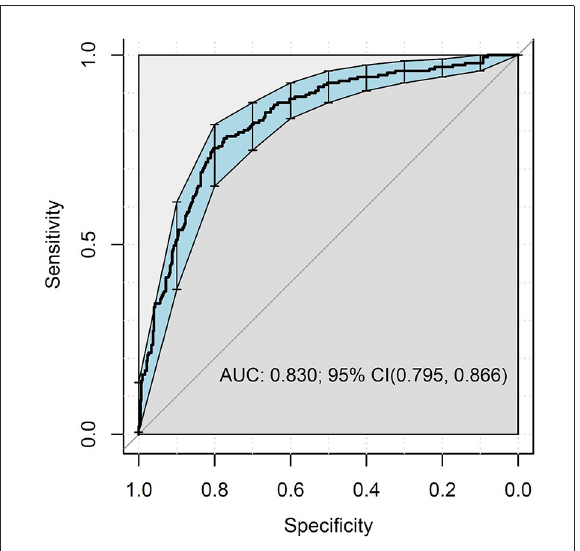
FIGURE1 Area under the receiver operating curve of the predictive models of increased suicide risk.